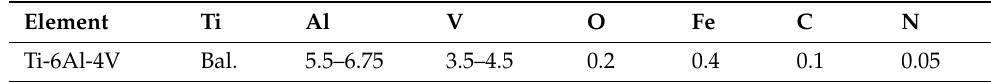
Table 1. Chemical composition of Ti-6Al-4V